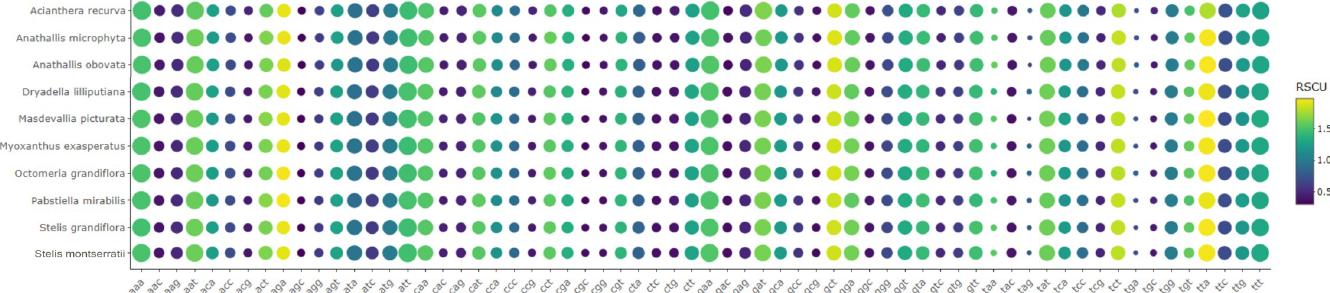
PLOS ONE | https://doi.org/10.1371/journal.pone.0256126 August 27,